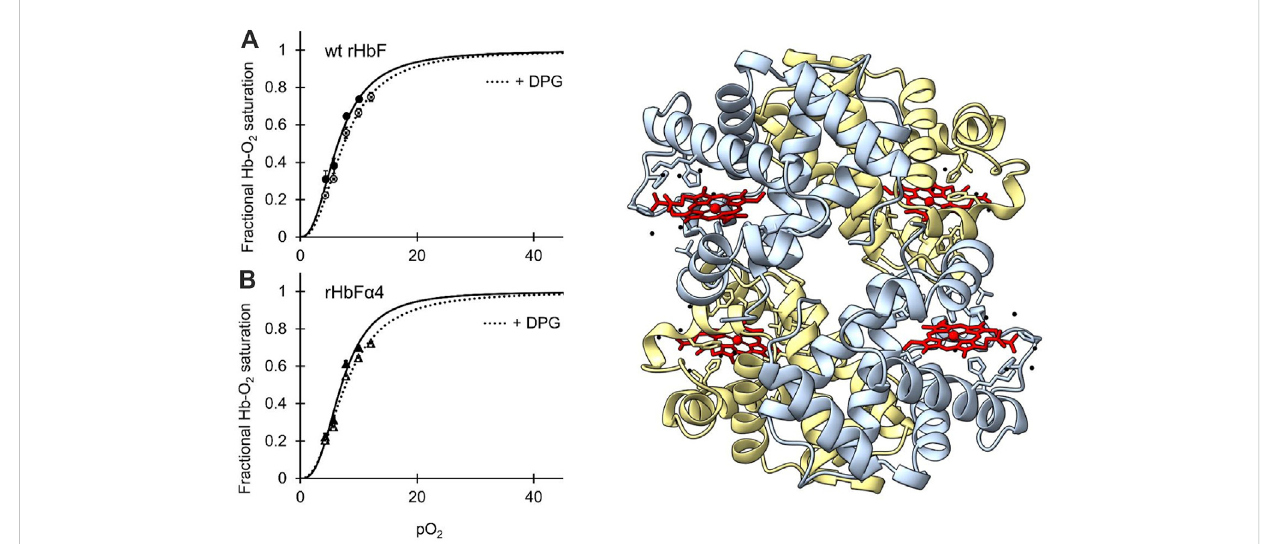
FIGURE 3 [IN COLOR] Oxygen binding curves of wt HbF (A) and HbF α 4 mutant (B) at 37 ° C, at a Hb concentration of 0.3 mM heme in 0.1 M HEPES buffer pH7.4supplementedwith0.1 MKCl.Solidlinesrepresenttheoxygen-bindingcurvewithouttheadditionofDPG,whilethedottedlinesshowtheoxygen binding with 0.75 mM DPG present. To the right of the graphs, the 3D structure of mutant rHbF α 4 obtained by X-ray crystallography is shown (PDB database entry code: 7QU4). The α -subunits are colored light blue and the γ -subunits are light yellow. The heme groups are shown in red while water molecules are colored black. The fi gure was created in the UCSF ChimeraX molecular visualization program (Goddard et al.,